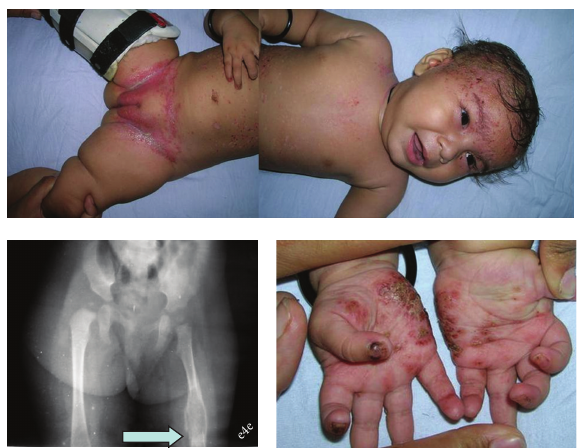
Figure 1: Picture showing the clinico-radiological presentation of the